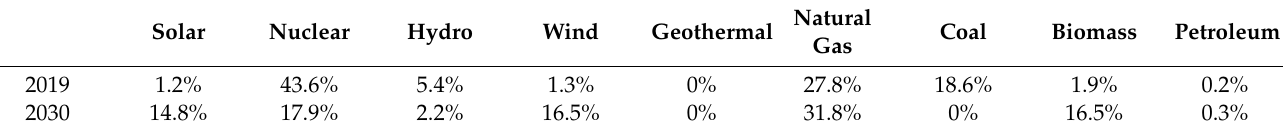
Table 3. Electricity generation by energy source simulated for year 2030.